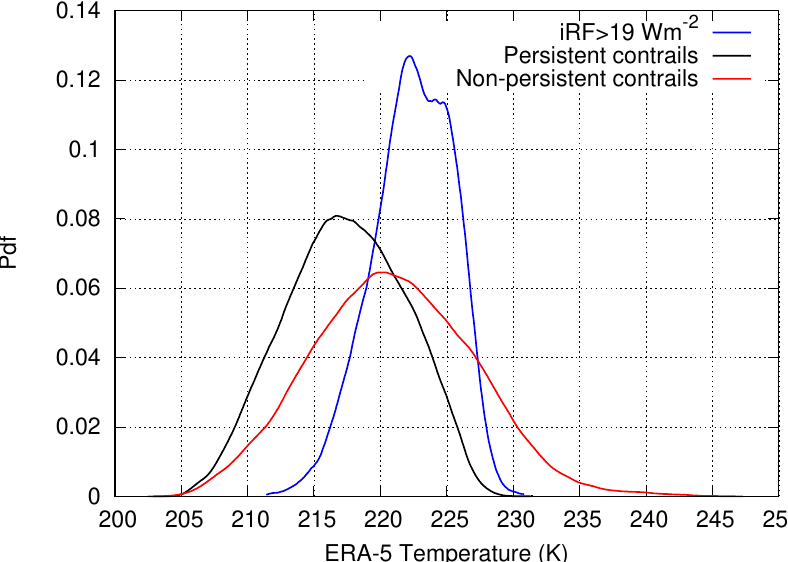
Figure 1. Temperature probability density functions (pdfs) in general situations without persistent contrails (red), in situations that allow persistent contrails (black), and in situations for persistent contrails that have a particularly large iRF (blue). The pdfs comprise the temperatures that ERA-5 reanalysis data show for the respective flight points from MOZAIC. Note that the deciding factors for persistence are MOZAIC’s thermodynamic quantities.